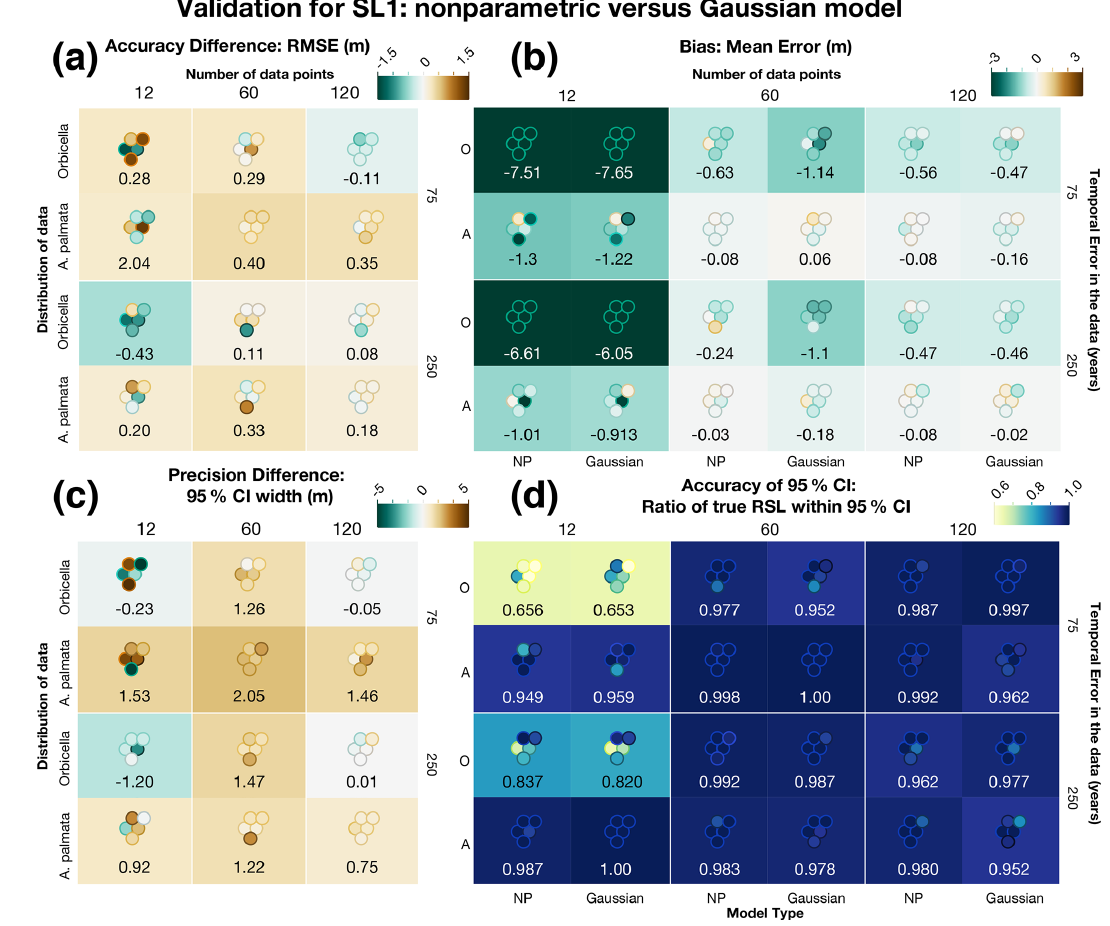
Figure 7. Comparison of several metrics to validate the new nonparametric (NP) model against the Gaussian model with the same exact data using sea-level curve SL1. The Gaussian model includes the same quantity of data as the nonparametric model but approximated with normal distributions instead of with kernel densities for both Orbicella spp. (O) and Acropora palmata (A). The differences (a, c) represent the Gaussian metric minus the nonparametric metric. The box colors represent the average metric value (also shown numerically), and each dot represents the individual test, positioned to match the corresponding test run. (a) The difference in the average accuracy of the models, measured by the root-mean-square error (RMSE). (b) Average bias for each model, measured by the mean error, where brown (green) represents positive (negative) bias. (c) The difference in the precision of model predictions, measured by the width of the 95% credible interval (CI). (a, c) Brown (green) values are positive (negative), signifying that the nonparametric model had less (more) error or more (less) precision. (d) Average accuracy of the uncertainty intervals, measured by the ratio of true values within the 95%CI. Darker blues represent more coverage (better performance). (b, d) The model type is shown at the bottom of each column. Individual test results for all metrics are shown in Table